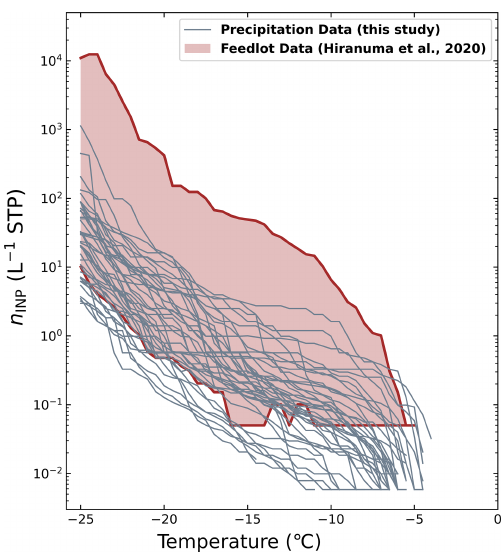
Figure 5. Compiled IN spectra of our precipitation samples su- perimposed on nucleation spectra from a local cattle feedyard dust study (shaded area). The cattle feedyard INP data are adapted from Hiranuma et al.